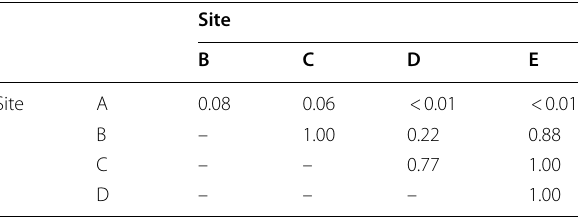
Table 2 p values for multiple comparisons of number of